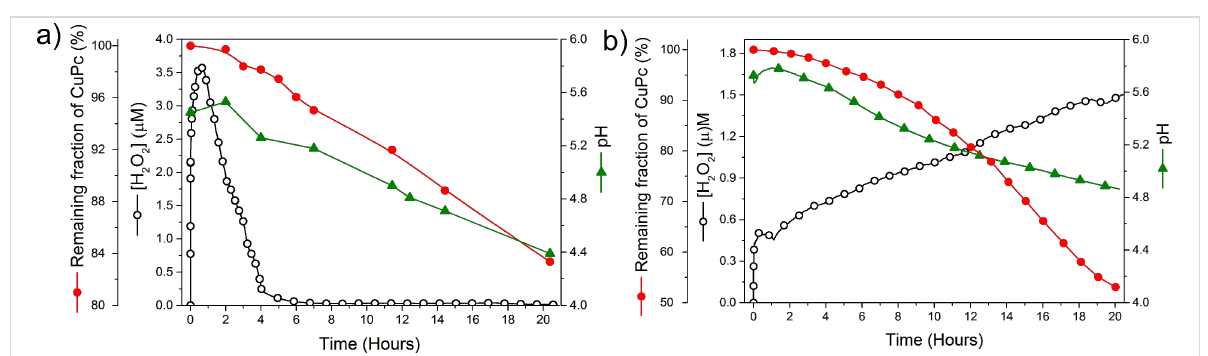
Figure 7: The pH and H 2 O 2 evolution in CuPc solutions with pyrite nanoparticles (a) [CuPc] 0 = 5 mg/L at 0.06 g/L loading (b) [CuPc] 0 = 0.1 mg/L at 0.04 g/L